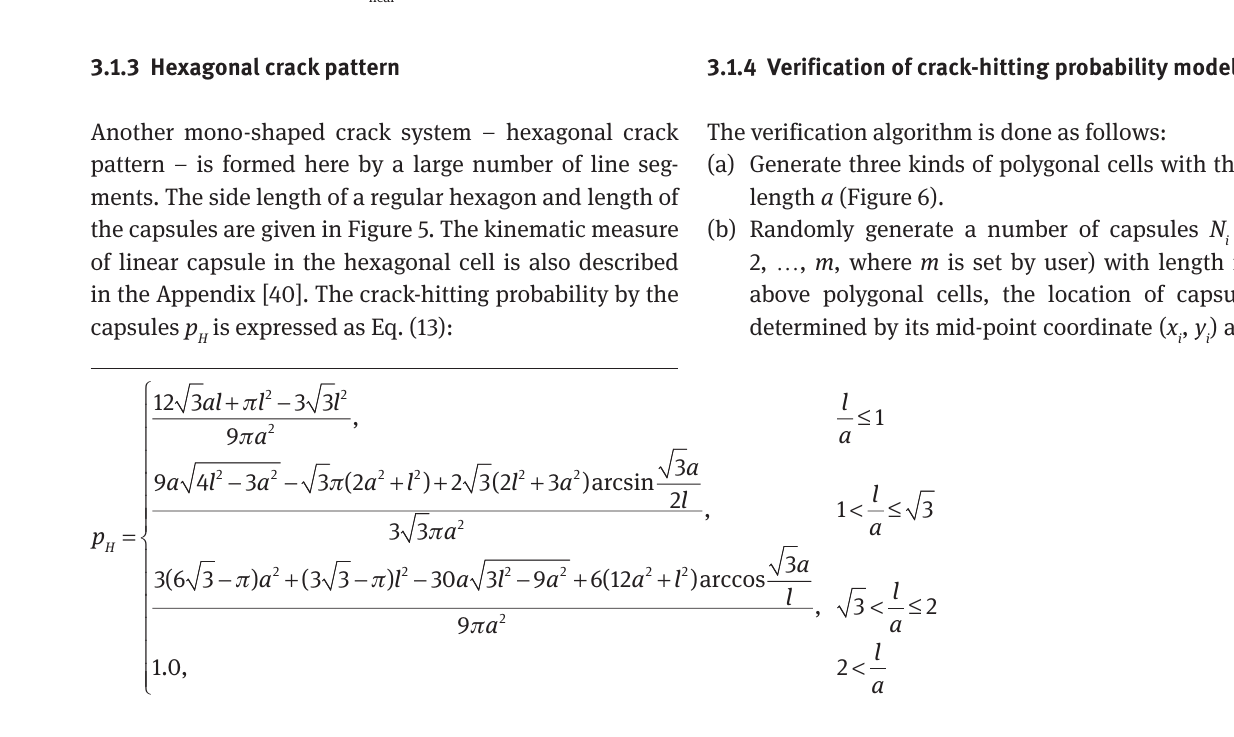
, are obtained by Eqs. T